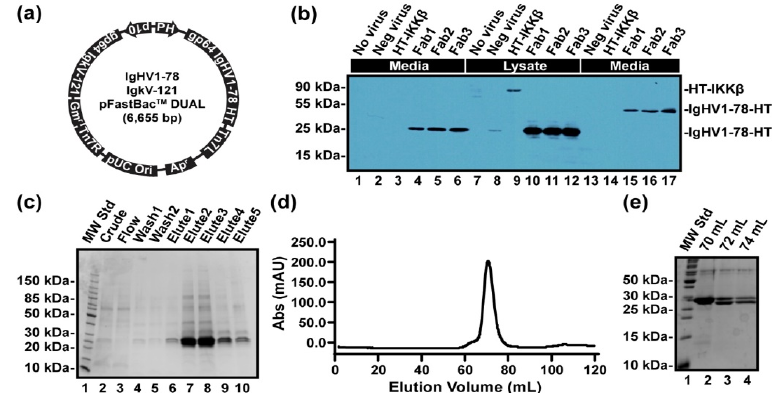
Figure 6. Expression and purification of LT1002 germline-encoded precursor Fab fragments from Sf9 insect cell suspension cultures. ( a ) pFastBac Dual plasmid with both heavy and light chain inserted and polyhedrin promoter for the heavy chain and p10 promoter for the light chain was designed. Signal peptide gp64 was used to secret the antibody. ( b ) Anti-His Western blot detection of secreted metalloantibody precursor Fab fragment from P1 baculovirus-infected Sf9 cells. 1, 2, and 3 secreted Fab antibodies, 4. negative control (cells with no virus), 5. negative control (intact virus), 6. IKK (Intracellular protein control), 7, 8, and 9 intracellular Fab antibodies, 10, 11, and 12 negative control, 13,14, and 15 secreted non-denaturing Fab antibodies. ( c ) Coomassie-stained 15% SDS PAGE gel for samples from Ni column purification. The size of the Fab antibody was 24kD, and the E2-E4 elutes contained most of the combined proteins. The double bands show heavy and light chains of the antibody. ( d ) Size exclusion chromatography using Superdex 75 16 / 60 of the His-tagged Fab antibody. ( e ) Coomassie-stained 15% SDS PAGE gel indicating the fractions from SEC column purification.